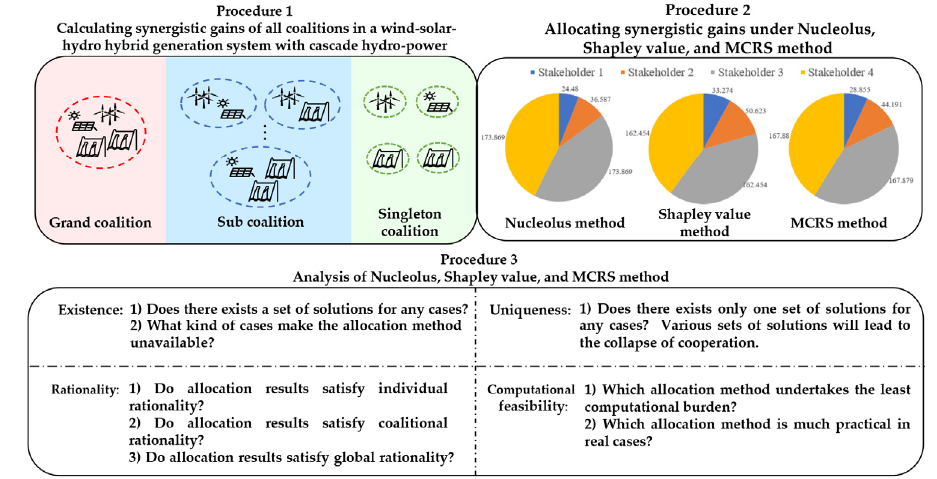
Figure 1. Three major procedures of this paper.